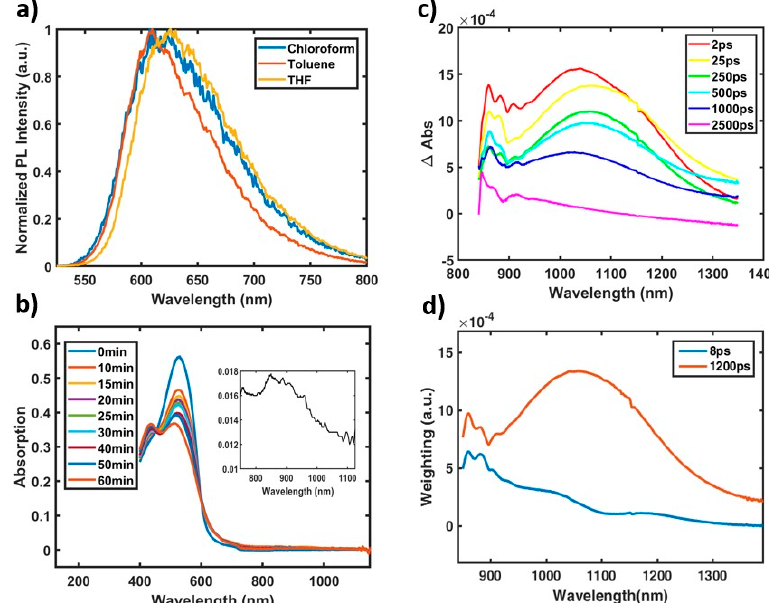
Figure 4. a ) Integrated, normalized time-resolved fluorescence from 200 ps onwards of n = 2